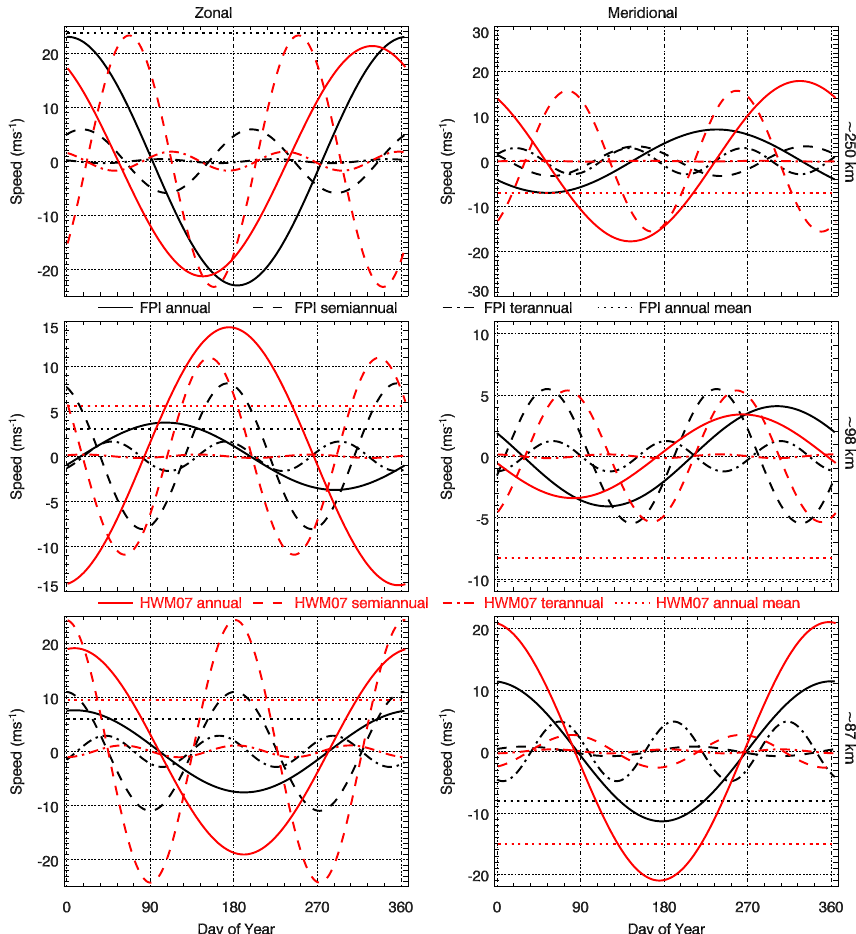
Fig. 5. Harmonic components of annual (solid line), semiannual (dash line), and terannual (dash dot line) variations and the annual mean (dot line) for midnight zonal (eastward positive) and meridional (northward positive) winds obtained from FPI (black) and HWM07 (red) at the altitudes of ∼ 87km (lower row), ∼ 98km (middle row), and ∼ 250km (upper row), respectively. The annual midnight model zonal wind mean and observation meridional wind are, respectively, 39.7 and − 35 . 7ms − 1 , which are out of the plotted range in Fig.